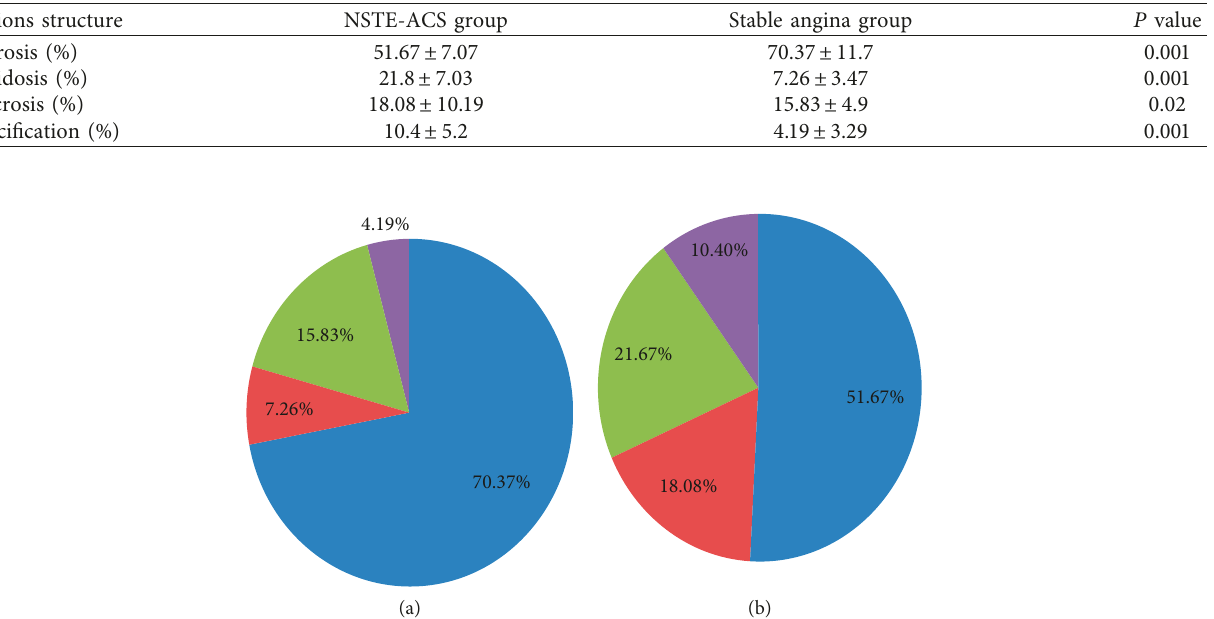
Table 4: Intravascular ultrasound characteristics of coronary lesions.